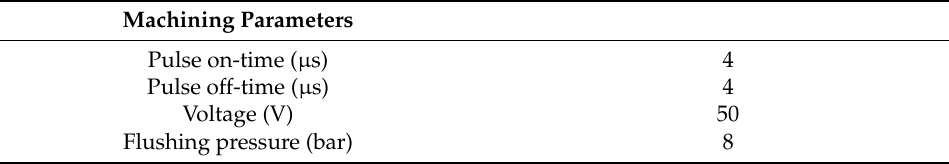
Table 4. Machining parameters (wire EDM).